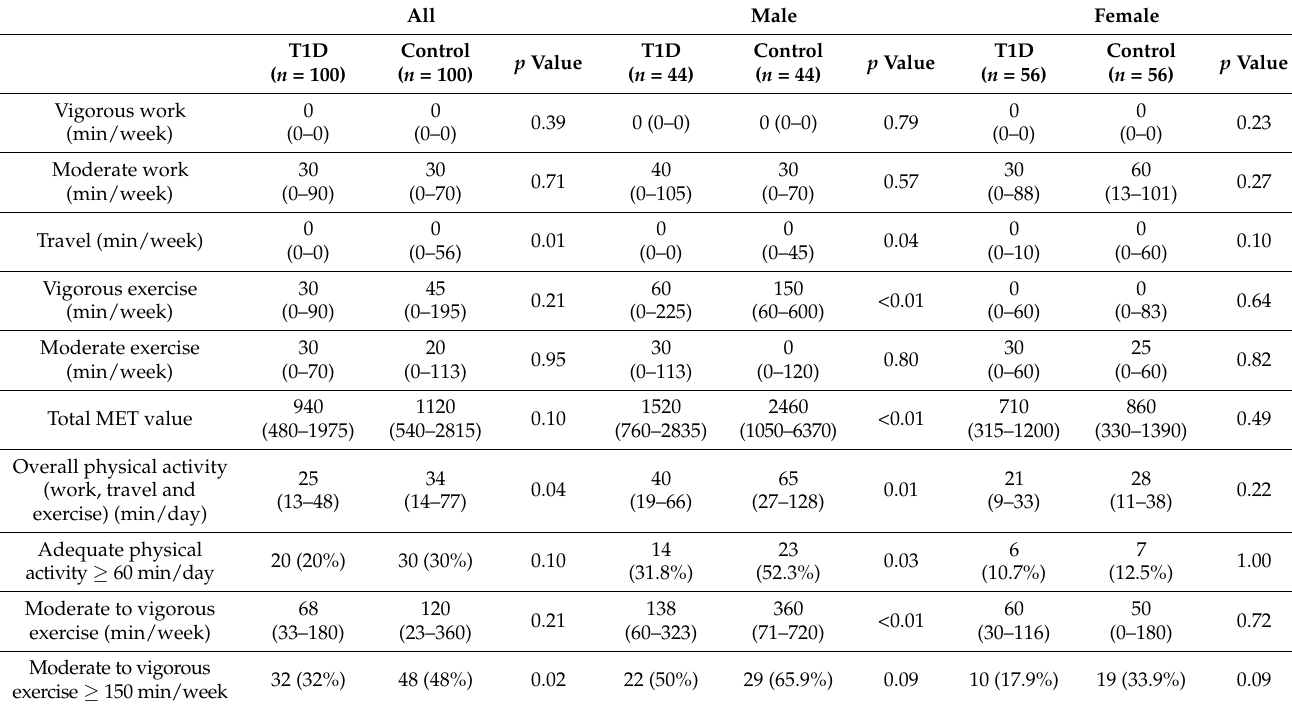
Table 5. Physical activity during a typical week within the previous month compared between those with and without type 1 diabetes for the entire study population, for male study participants, and for female study